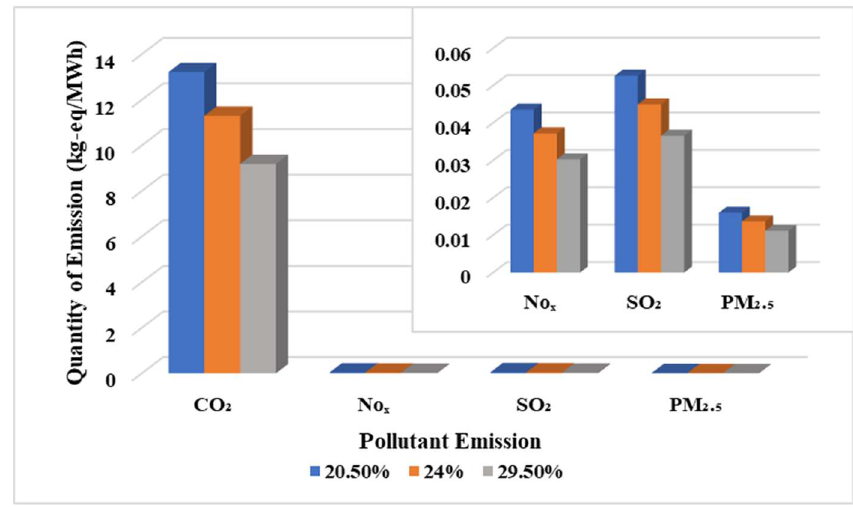
Figure 8. Variation in CO 2 emissions at the varying capacity